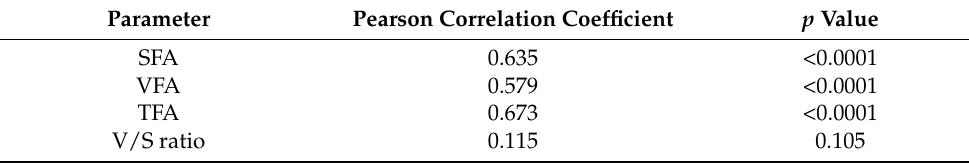
Table 3. Correlation analysis between BMI and body fat parameters on imaging. Parameter Pearson Correlation Coefficient p Value SFA 0.635 <0.0001 VFA 0.579 <0.0001 TFA 0.673 <0.0001 V/S ratio 0.115